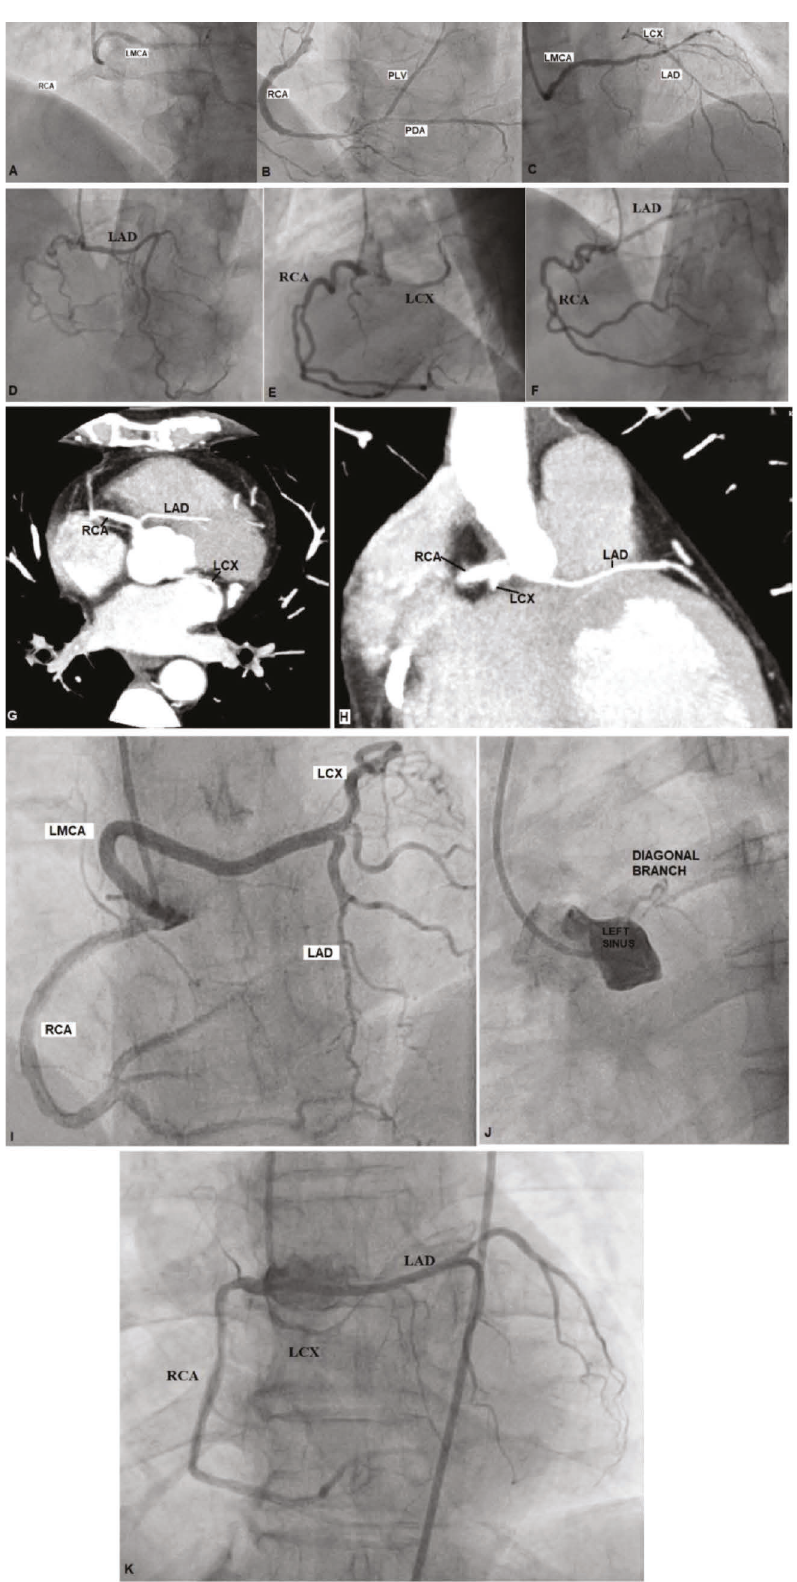
Figure 2: (a)–(c): CAG showing the origin of all 3 major coronaries from the right sinus of Valsalva. Dominant RCA showing 80–90% long tubular stenosis in mid to distal part along with 80% stenosis in proximal PDA. LMCA originates from the right sinus via common ostium with RCA and coursed retroaortic and then divided into LAD and LCX. LAD had long segment calcific 80% stenosis and LCX was distal diseased. (Case 3). (d)–(f): CAG showing single vessel disease with all 3 major coronaries originating from the right sinus via common ostium. LCX ran retroaortic with ostioproximal 95% thrombotic occlusion. LAD had mild plaque. Dominant RCA had 60% stenosis in the mid part. (Case 4). (g) & (h): CTcoronary showing all 3 major coronaries LAD, LCX, and RCA arising from the right sinus via the common trunk. RCA showed 90% stenosis in the mid part. (Case 5). (i) & (j): CAG showing anomalous origin of LMCA from the right sinus along with RCA via common ostium. The left main coronary traversedretroaortictowardstheleftsideanddividedintotheLADandLCXbranches.Asmalldiagonalbranchoriginatedfromtheleftsinus.(Case6). (k): CAG showing all 3 major coronaries LAD, LCX, and RCA originating from the right coronary cusp via the common ostium. (Case